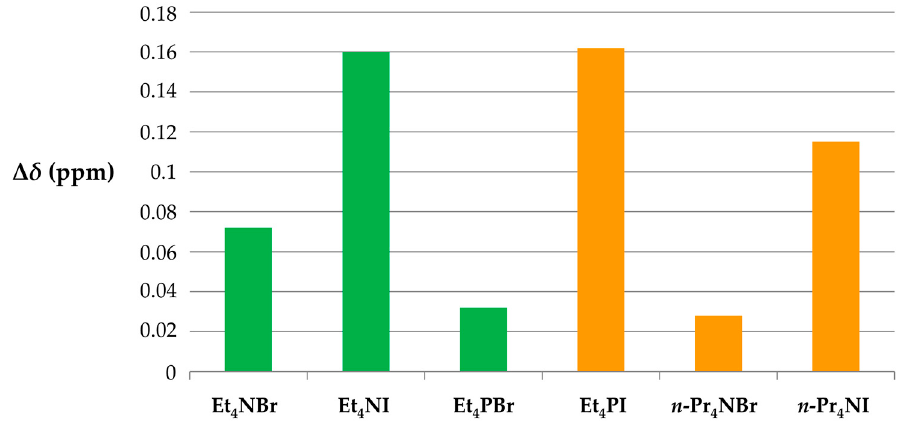
Figure 5. Variation of 19 F NMR chemical shift of 1,3,5-triidotrifluorobenzene ( 1 ) upon interaction with some onium bromides and iodides when 10 equivalents of the onium salt was added to a 5 mM solution of 1 in deuterochloroform.